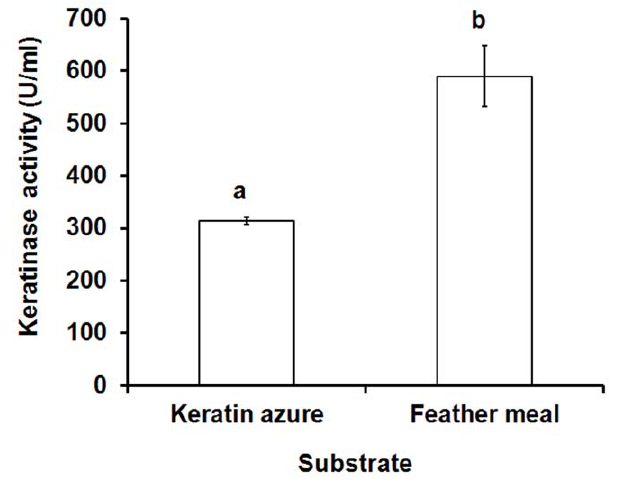
Figure 9. Enzymatic hydrolysis of different keratin. The values represent means 6 standard. a,b Mean values were significantly different (P , 0.05) when labeled with unlike letters.